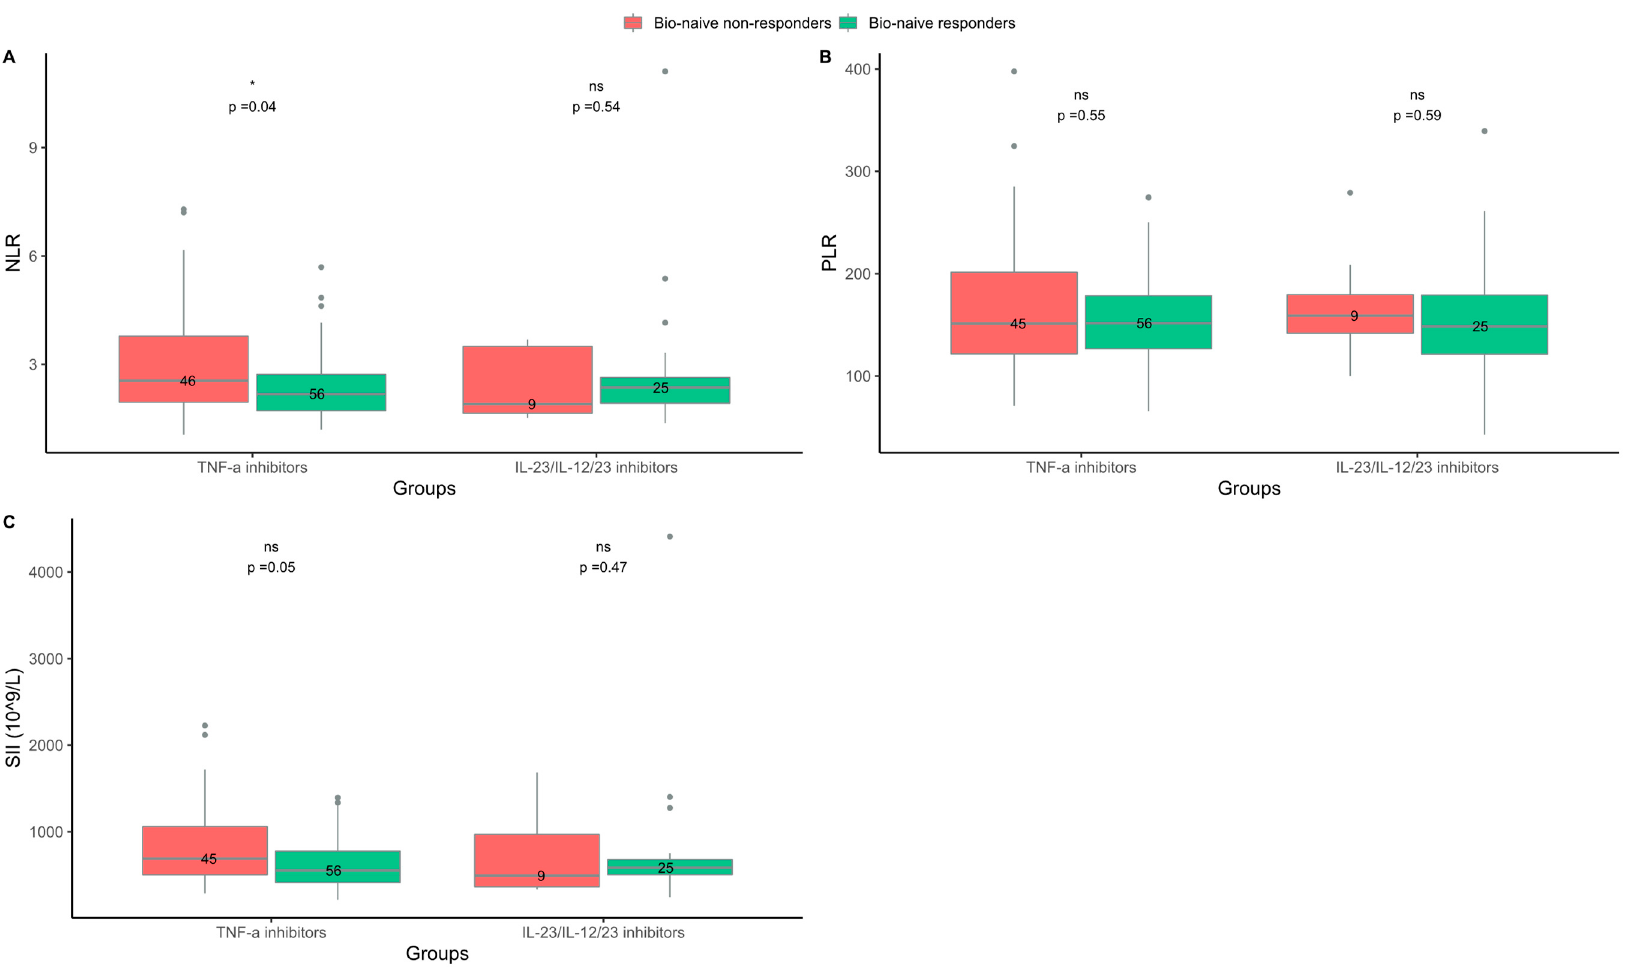
Figure 2. Blood cell biomarkers at baseline in bio-naive responders and non-responders treated with either tumor necrosis factor (TNF)- α inhibitors or interleukin (IL)-23/IL-12/23 inhibitors. ( A ) Neutrophil-to-lymphocyte ratio (NLR). ( B ) Platelet-to-lymphocyte ratio (PLR). ( C ) Systemic immune–inflammation index (SII). Responders = psoriasis area and severity index (PASI) ≤ 2 three months after treatment start. Non-responders = PASI > 2 three months after treatment start. ns = non-signi fi cant. * p < 0.05.